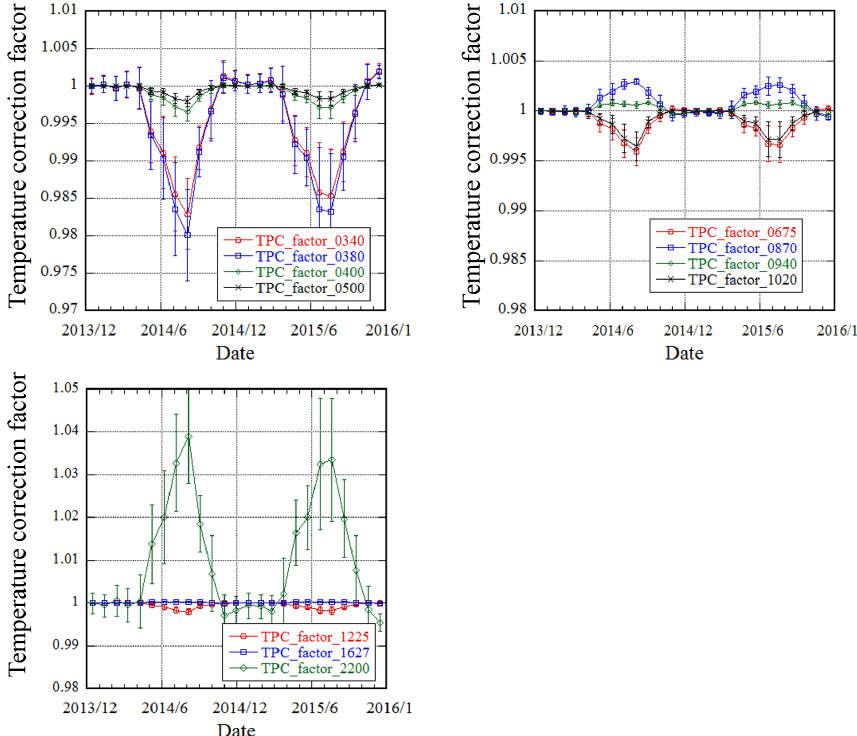
Figure 7. Monthly means of the temperature correction factors and standard deviation for POM-02 (Tsukuba) from December 2013 to December